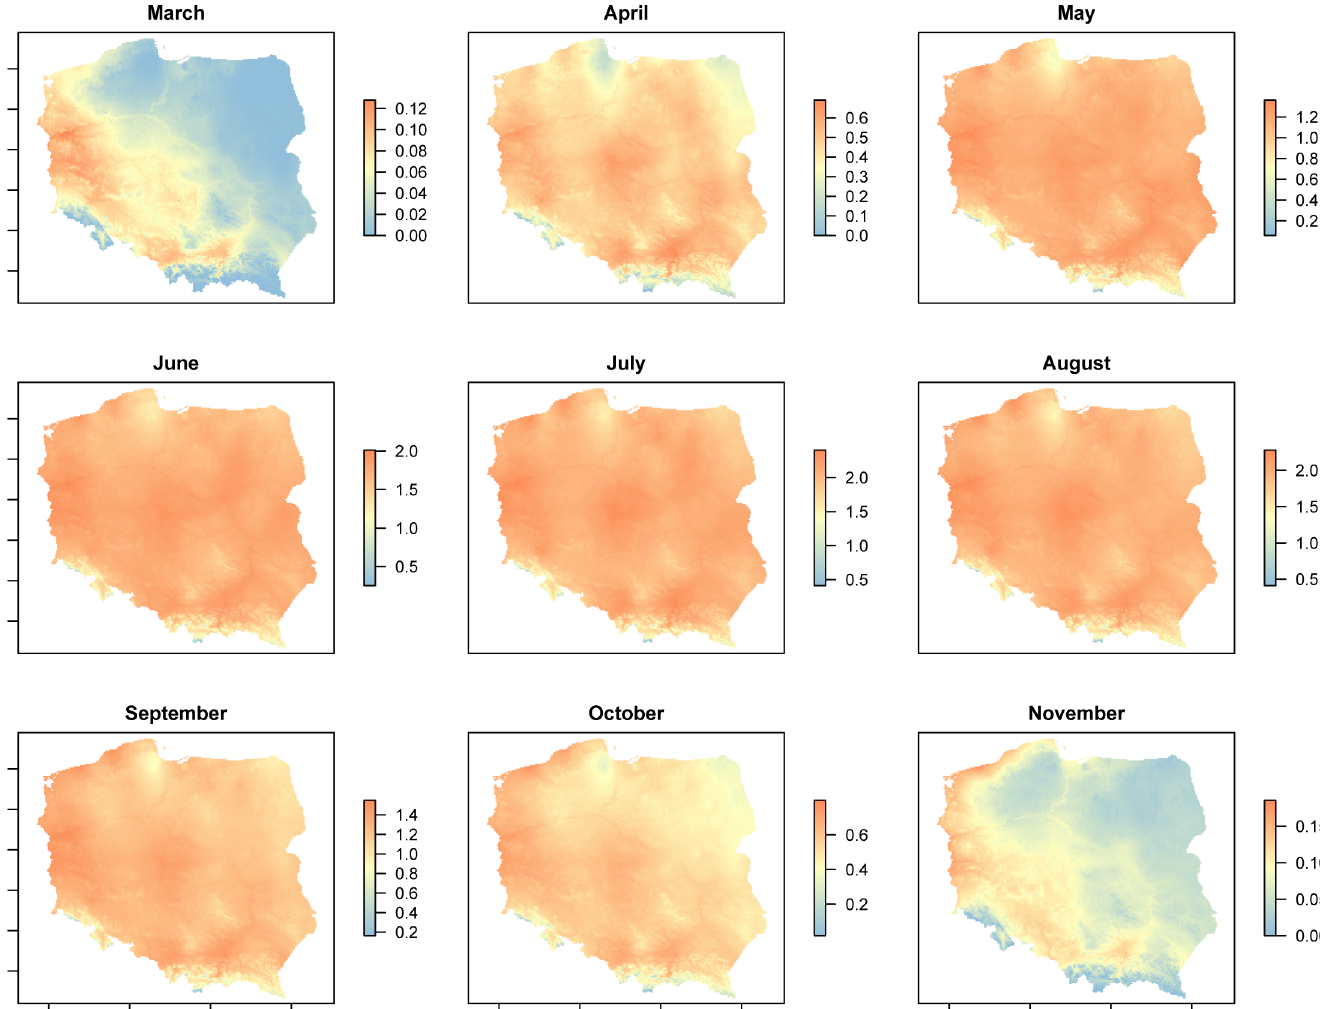
Fig 4. Spatial variation in intrinsic growth rate for Aceria tosichella lineage MT-1, predicted from fundamental thermal niche using mean monthly